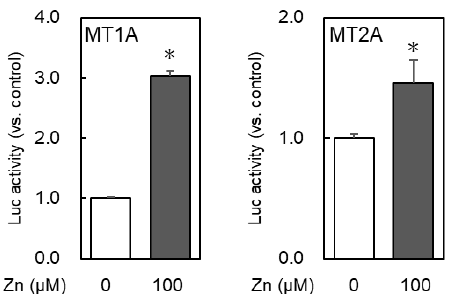
Figure 4. MTF1 co-expression effect on promoter MT1A and MT2A activity. HeLa cells were co- transfected with luciferase reporter vector, pRL-SV40 vector for internal control, and MTF1 expression vector. At 24 h after transfection, the cells were treated with zinc at the indicated concentrations for 6 h, and luciferase activity was measured using the dual-luciferase assay system. * p < 0.05 indicates significant difference from the untreated group.